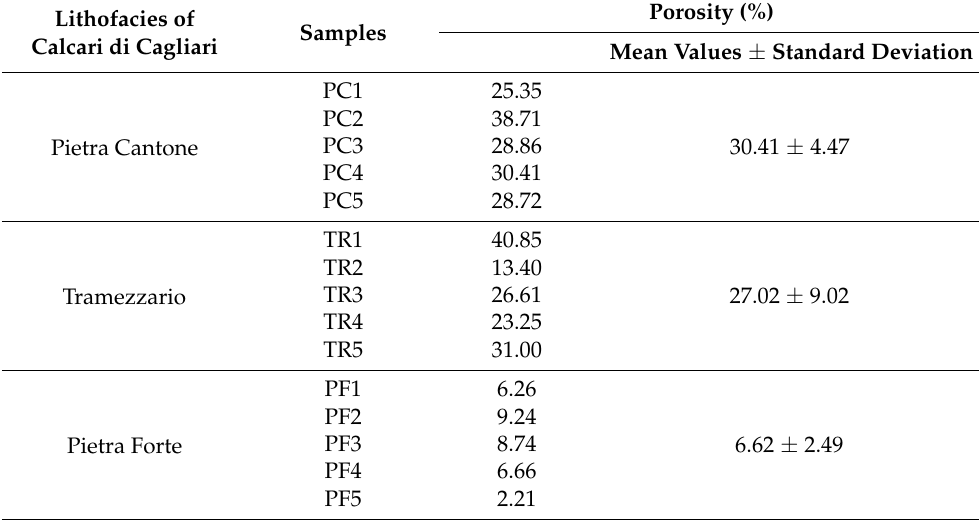
Table 1. Effective porosity of Calcari di Cagliari determined by MIP